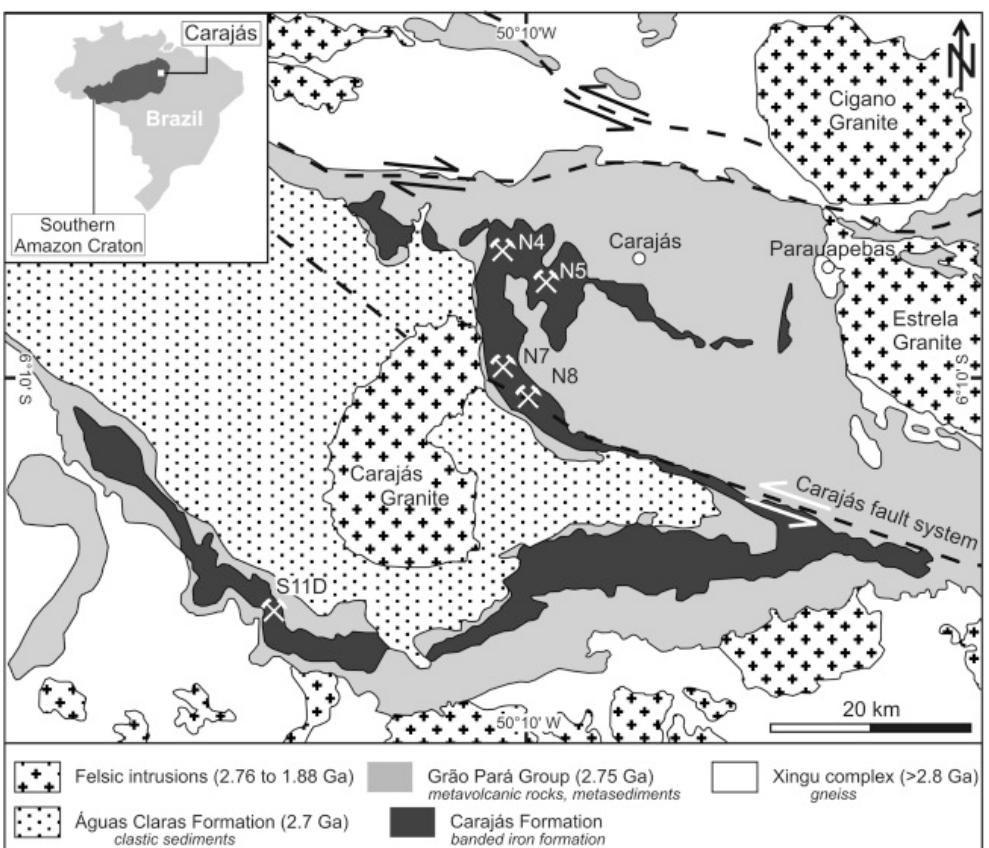
Figure 1. Geological map showing the Carajás Mineral Province in the context of the Amazonian Craton [5].